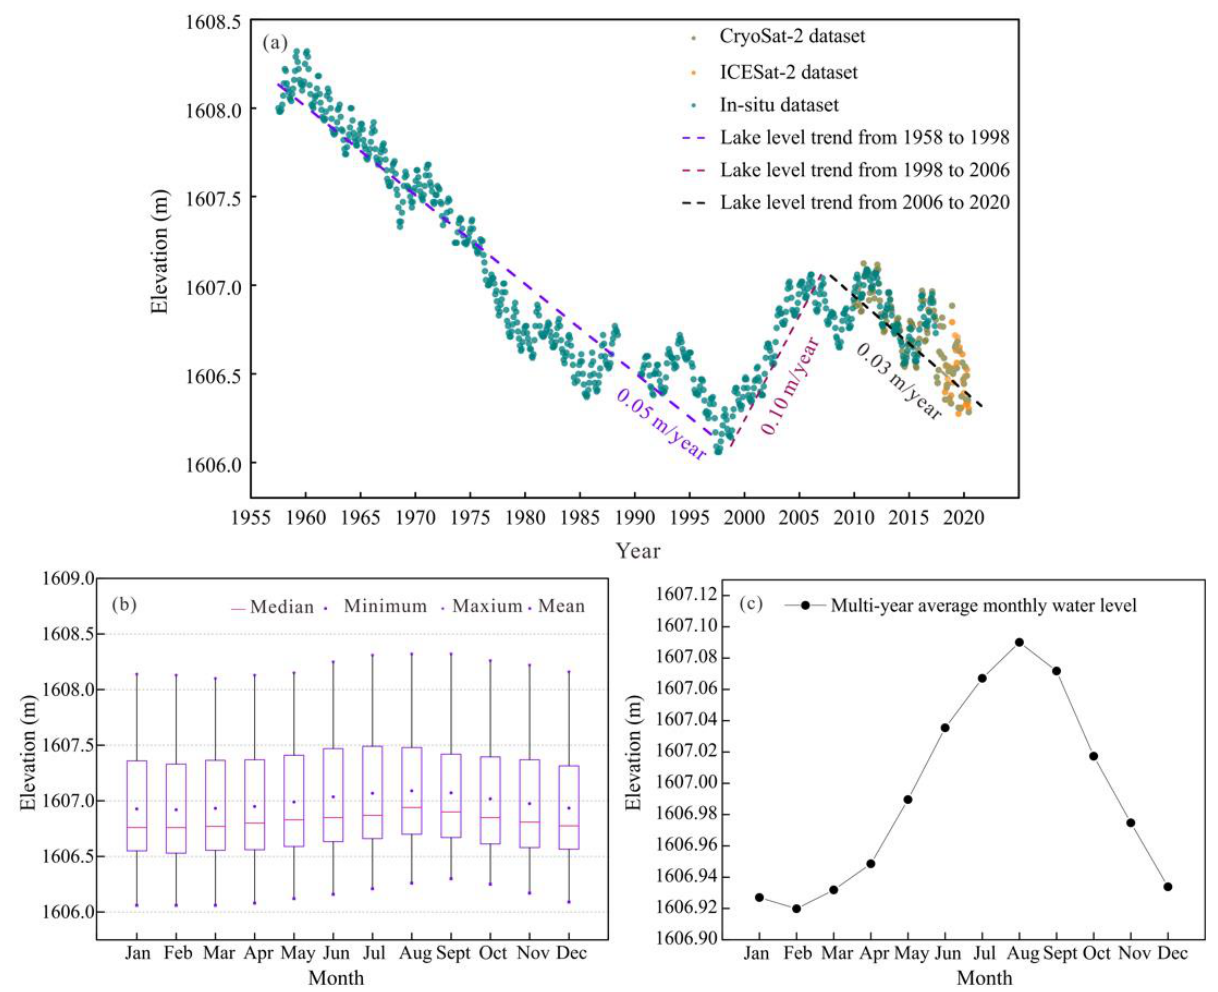
Figure 6. ( a ) Changes in the water level of Lake Issyk-Kul from 1958 to 2020. ( b ) Intra-annual variations in the water level of Lake Issyk-Kul. ( c ) Multi-year average monthly water level of Lake Issyk-Kul. The intra-annual variations in the water level of Lake Issyk-Kul indicated relatively regular seasonal variabilities (Figure 6b,c). The water level was relatively stable from January to March, and then gradually increased, reaching the maximum of 1607.09 m